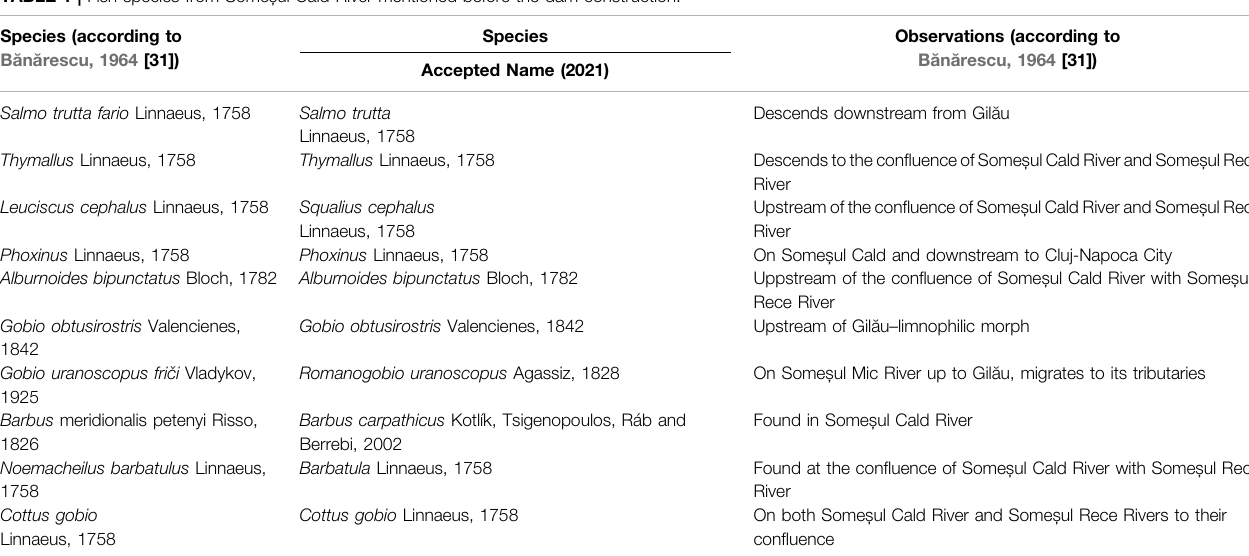
TABLE 1 | Fish species from Some ș ul Cald River mentioned before the dam construction. Species (according to B ă n ă rescu, 1964